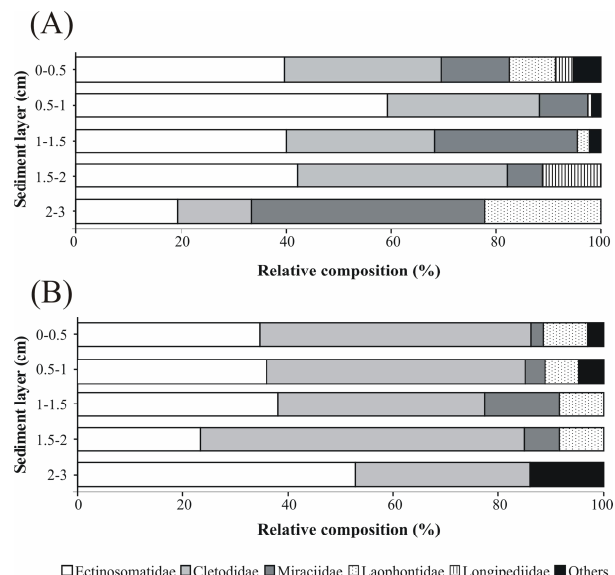
Fig. 5. Relative composition of the harpacticoid copepod families: vertical distribution in (A) normoxic and (B) anoxic conditions.